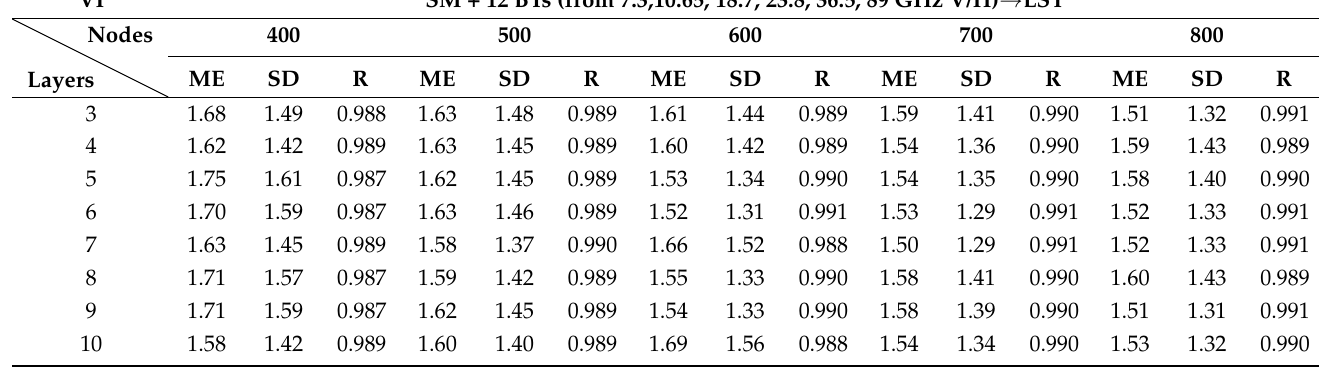
Table 6. SM and twelve channels are used to retrieve LST (SM and brightness temperature combina- tion of twelve channels).